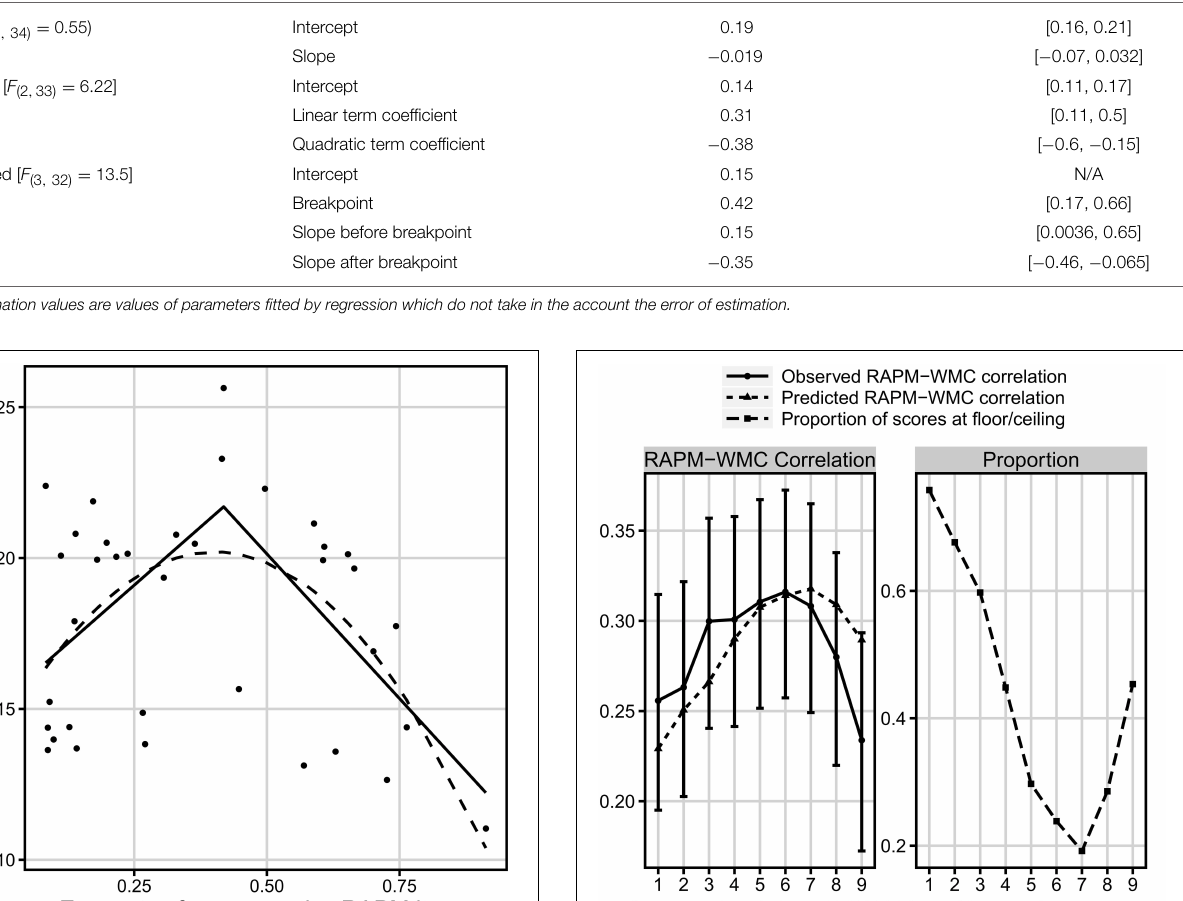
TABLE 3 | Confidence intervals for parameters of the regression analyses for the correlation of the Raven items with WMC (calculated from the short-term memory and relation integration tasks; N = 939 ) over difficulty of the items. Regression Parameter Point estimation value Linear [ F (1 , 34) 0 . 55 ) = Quadratic [ F (2 , 33) 6 . 22 ] =